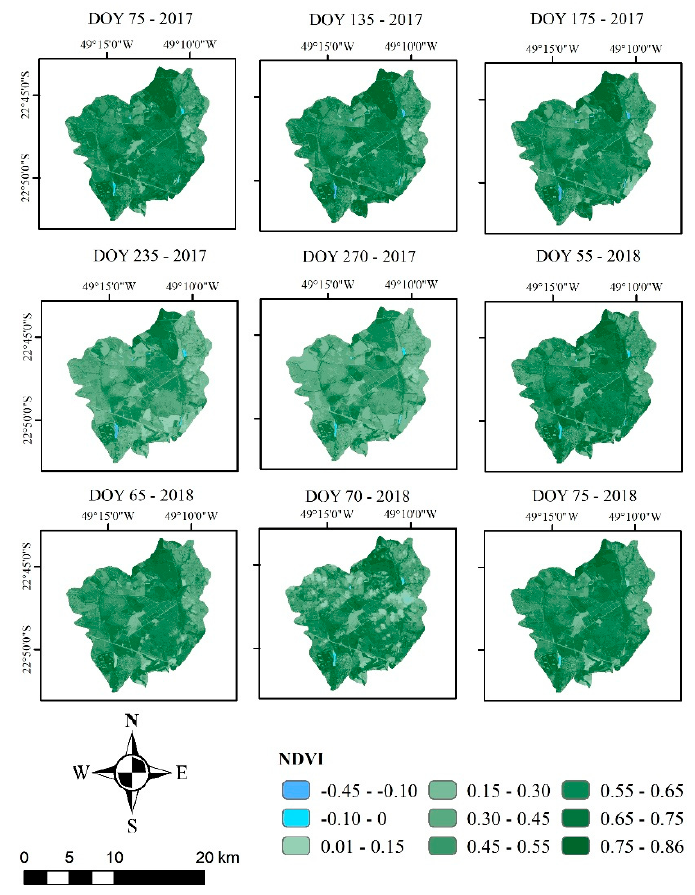
Figure 8. NDVI between 2017 and 2018 in watersheds with varied land use. (DOY = day of year). Table 4. Mean values and standard deviation of NDVI between 2017 and 2018 by land use and day of year (DOY). DOY Sugarcane Crop Pasture Silviculture Forest 75/2017